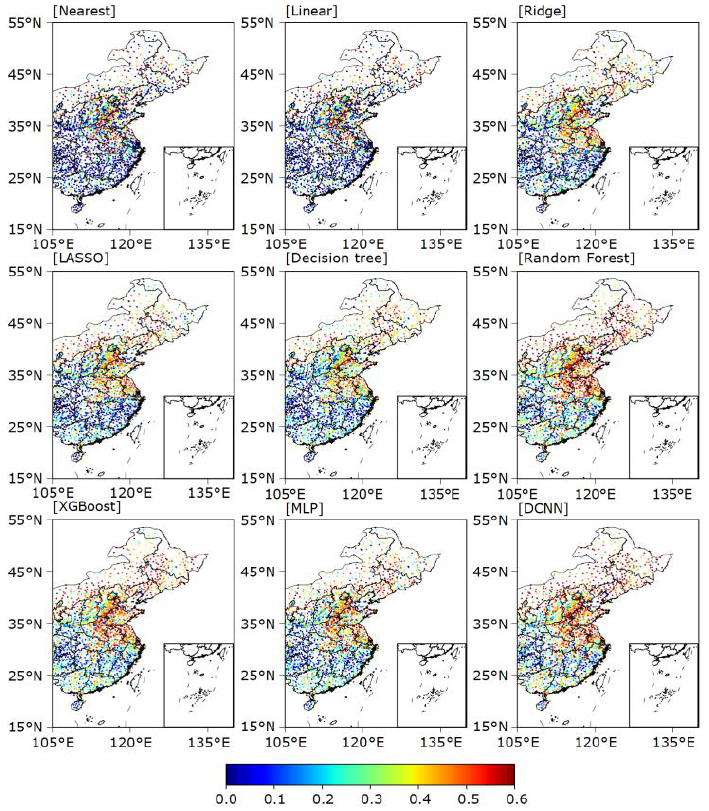
Figure 7. Spatial distribution of R 2 values for winter wind speeds across eastern China estimated by different interpolation methods.